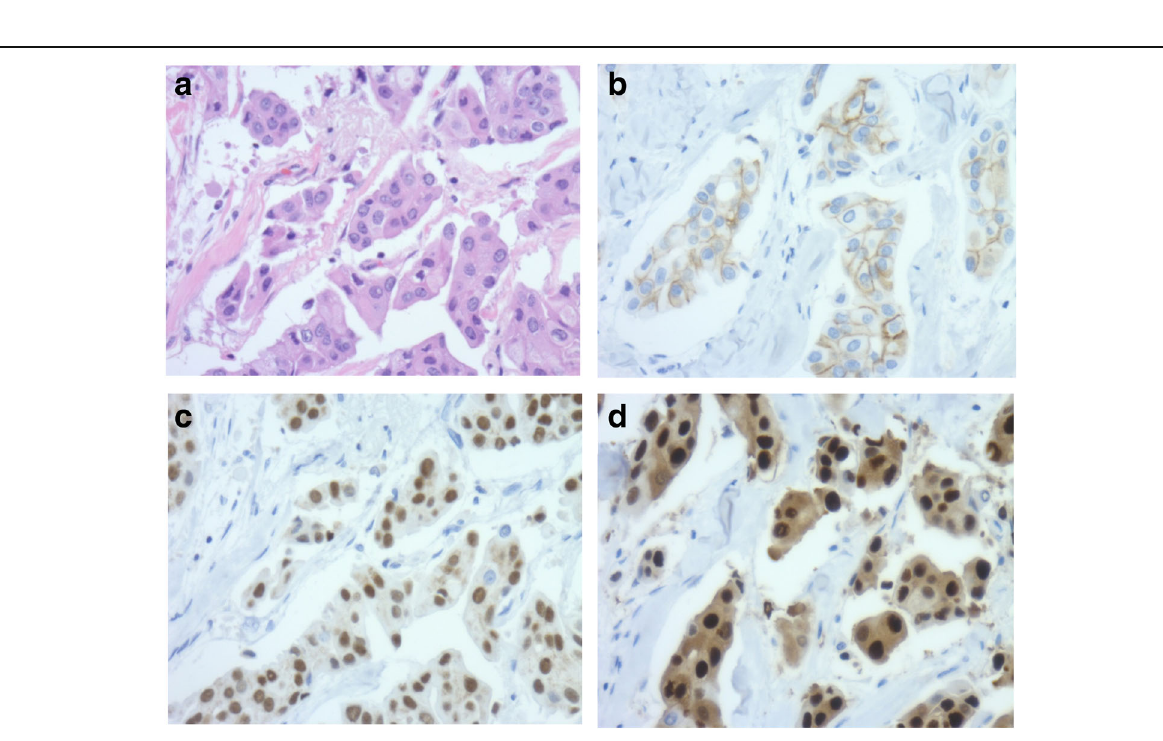
Fig. 5 Histopathological features of the tumor in this case. a Invasive micropapillary carcinoma (H&E staining, ×200). b Immunohistochemistry showed Her2 receptor 2+ (×200). c Estrogen receptor-positive staining of 100% (×200). d Progesterone receptor-positive staining of 100% (×200)